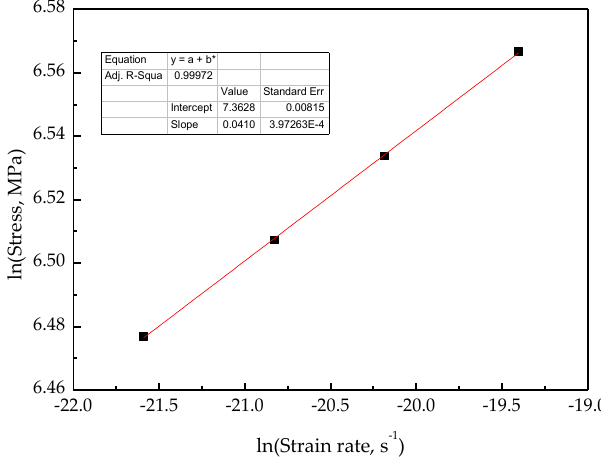
Figure 7. Variation of the creep stress with strain rate.